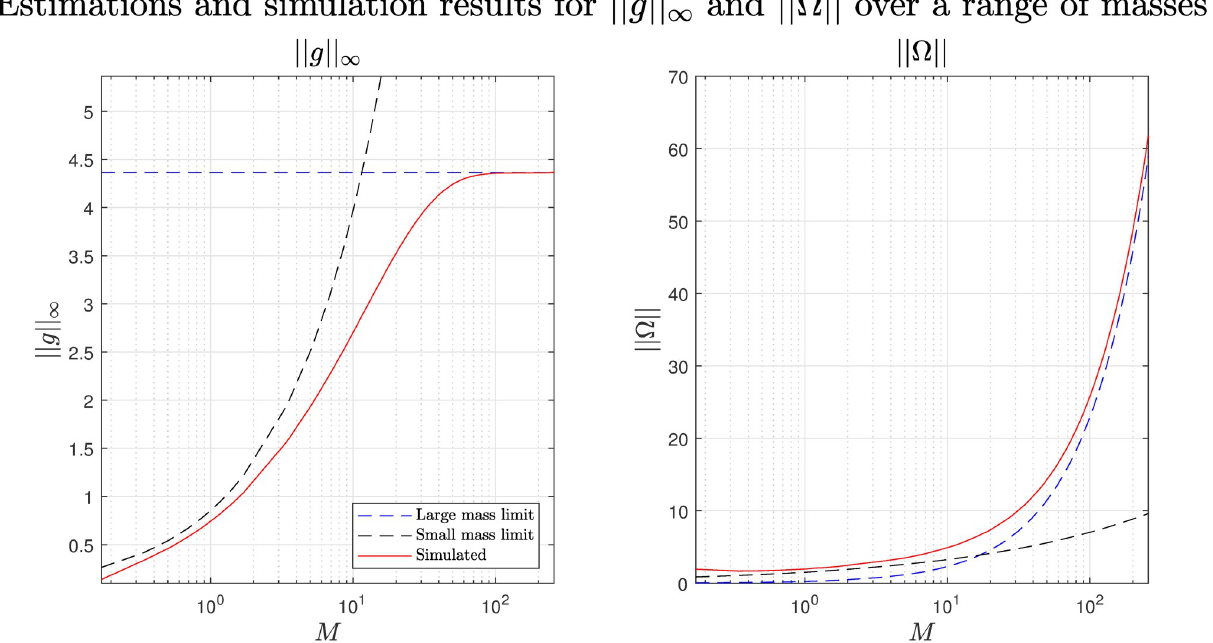
Fig 3. Small and large mass limit estimates and simulated results for both the maximum group density (left) and support (right). In the simulations we estimate the finite support, O , as the region where g > 0.01.